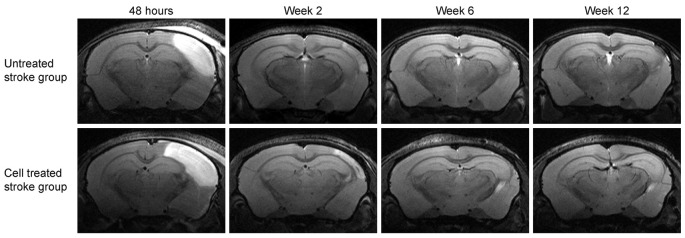
Lesion development on T2-weighted MRI at the level of the hippocampus. Representative animals for both groups involving stroke are shown. The image slice position at the level of the hippocampus was chosen equivalent to the second most caudal section in Figure 2. While the affected cortical area is visible at the acute time point at 48 h after stroke induction, the hyperintensity decreases with resolving vasogenic edema at 2 weeks. At 6 weeks and 12 weeks, both, the cortical tissue loss and the shift of the hippocampus towards the brain surface, become prominent.